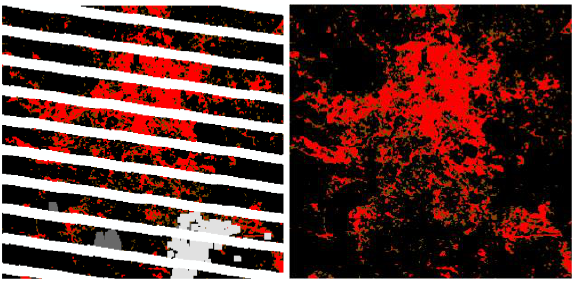
Figure 4. Landsat 7 April 2008 image showing scan errors